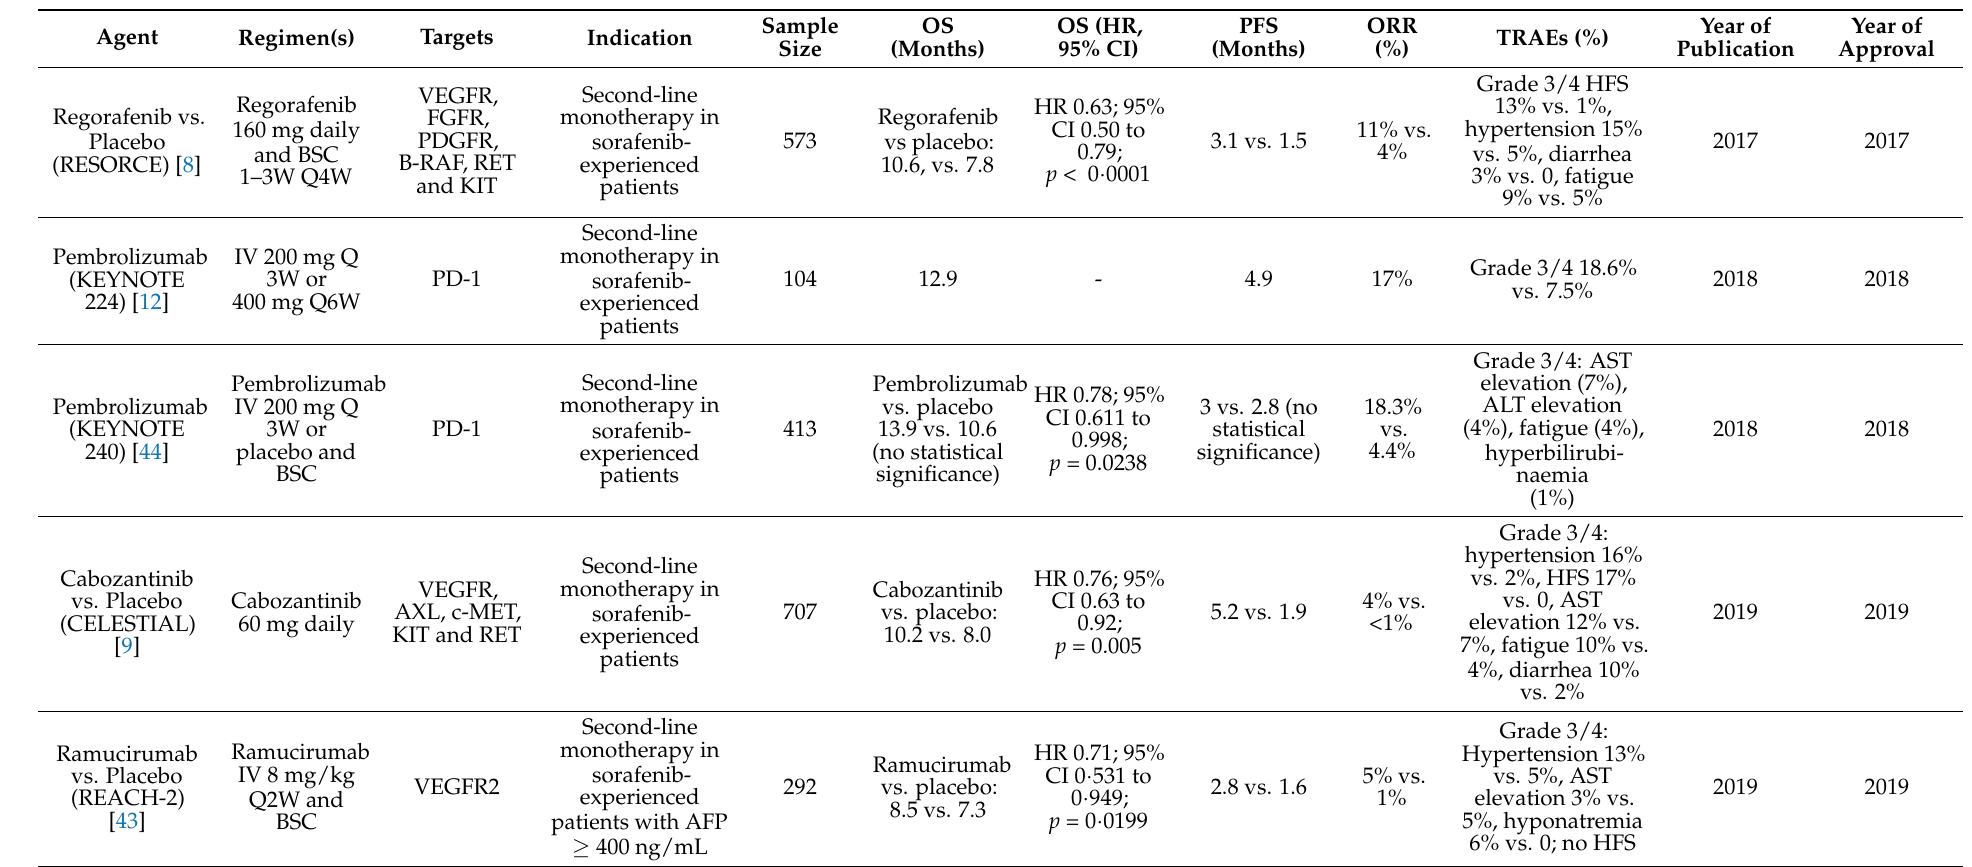
Table 2. Second-line systemic therapies for advanced